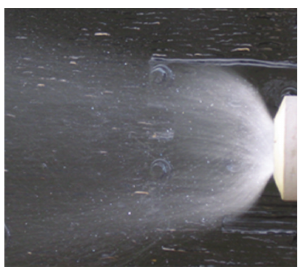
Figure 6: Visual droplet size at 4.2 L/min water flow with air- injected e ff ervescent